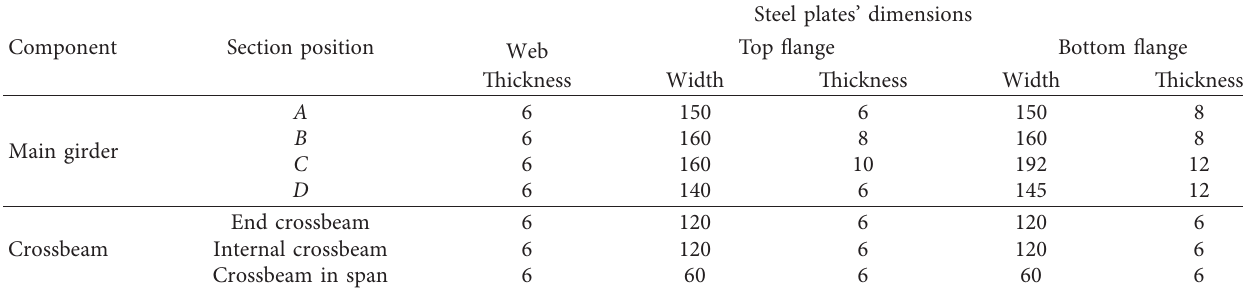
Table 1: The detail dimensions of all steel plates (unit: